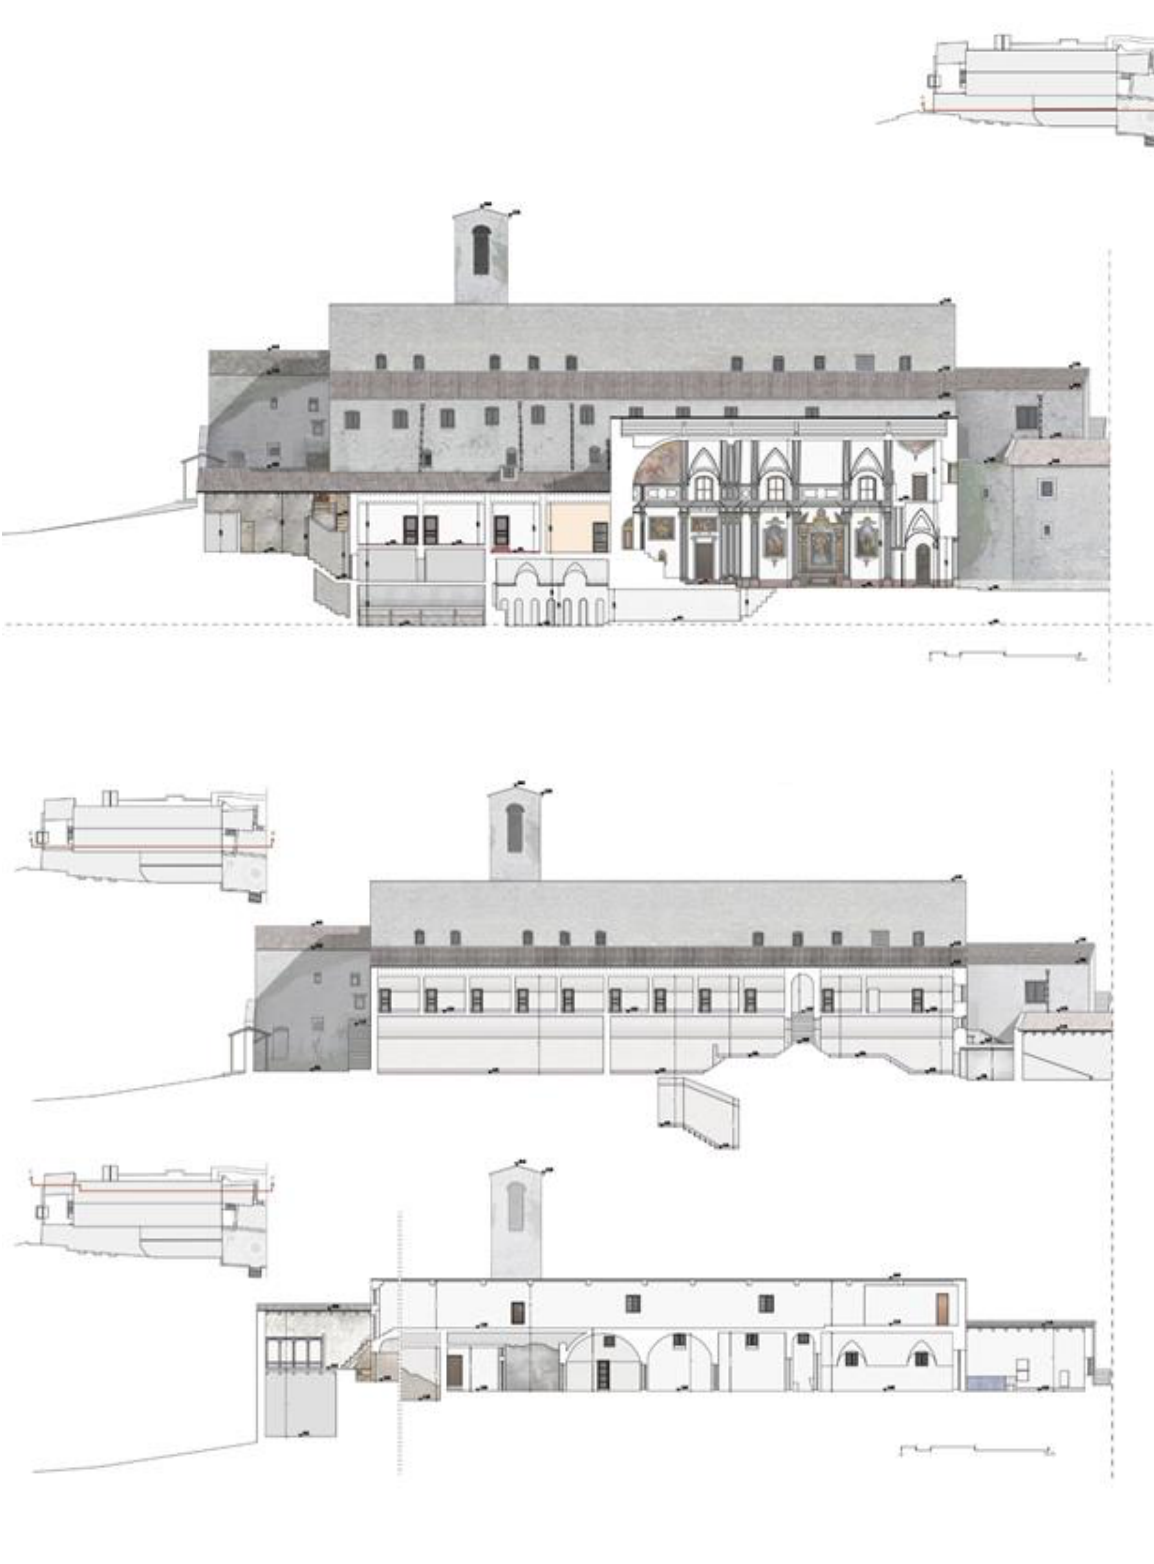
Figure 10. Transversal sections of the building at different levels and plant